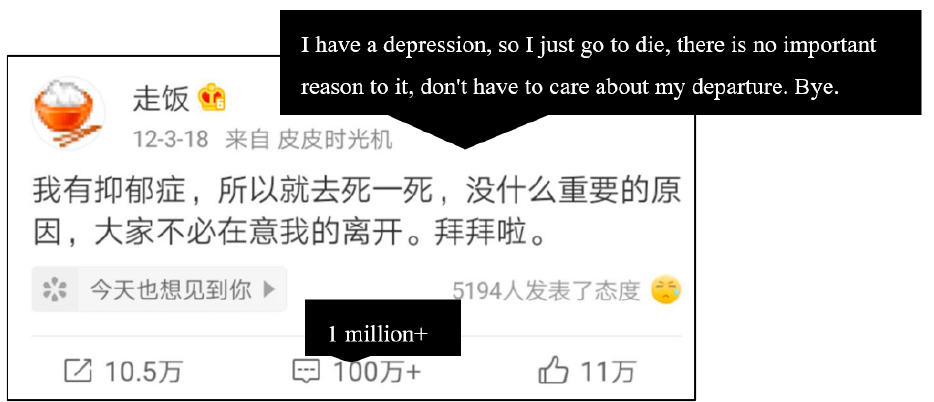
Figure 2. The last Weibo post of Weibo user “Zoufan”.